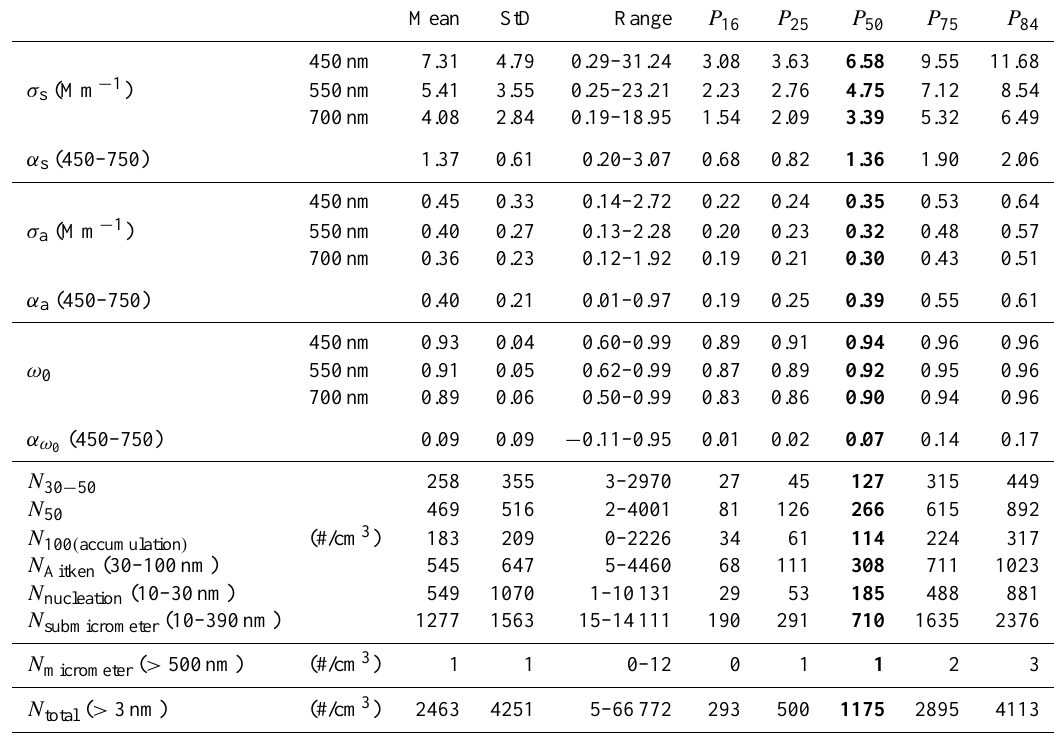
Table 1. Evaluation of the overall ranges and arithmetic mean values of the absorption/scattering coefficients, the ˚Angstr¨om exponents, the single scattering albedo and the concentrations in each size section obtained from the data set measured at ALOMAR. P x values are the x-th percentage of the considered parameter. The median value ( P 50 ) is listed in